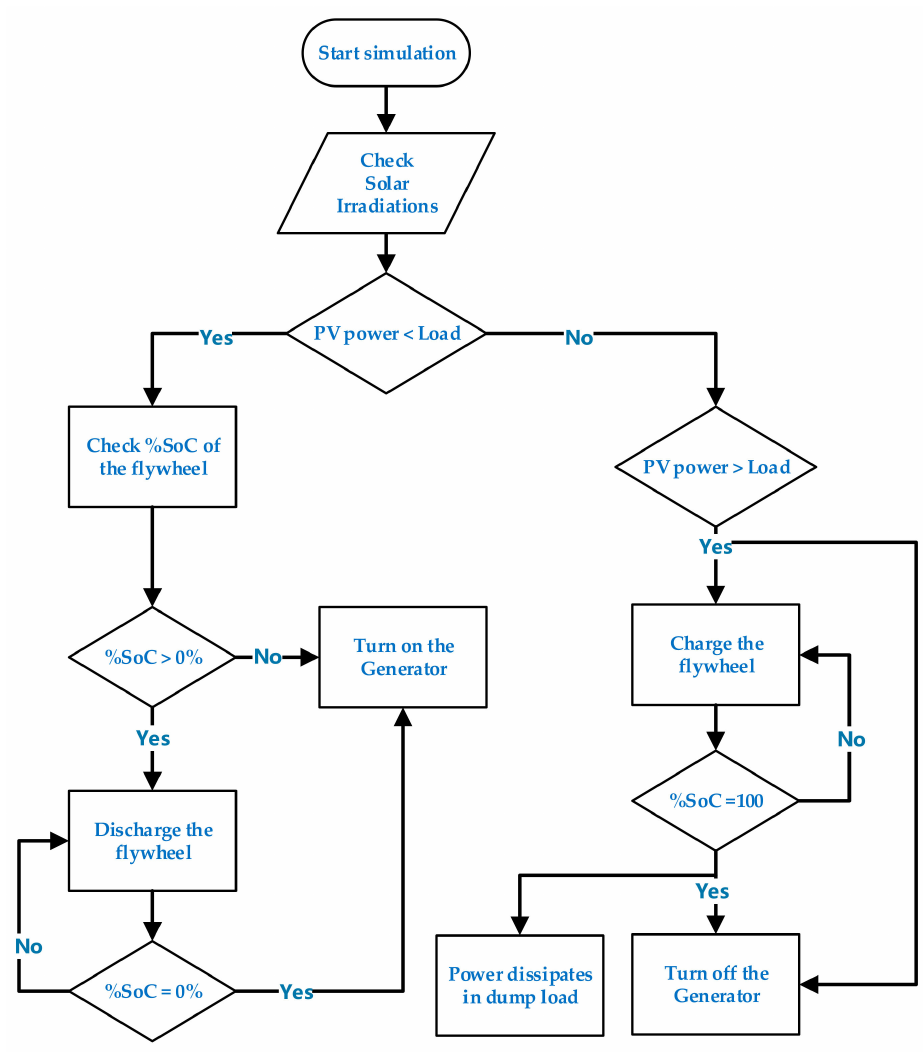
Figure 11. Logic Control Scheme of proposed